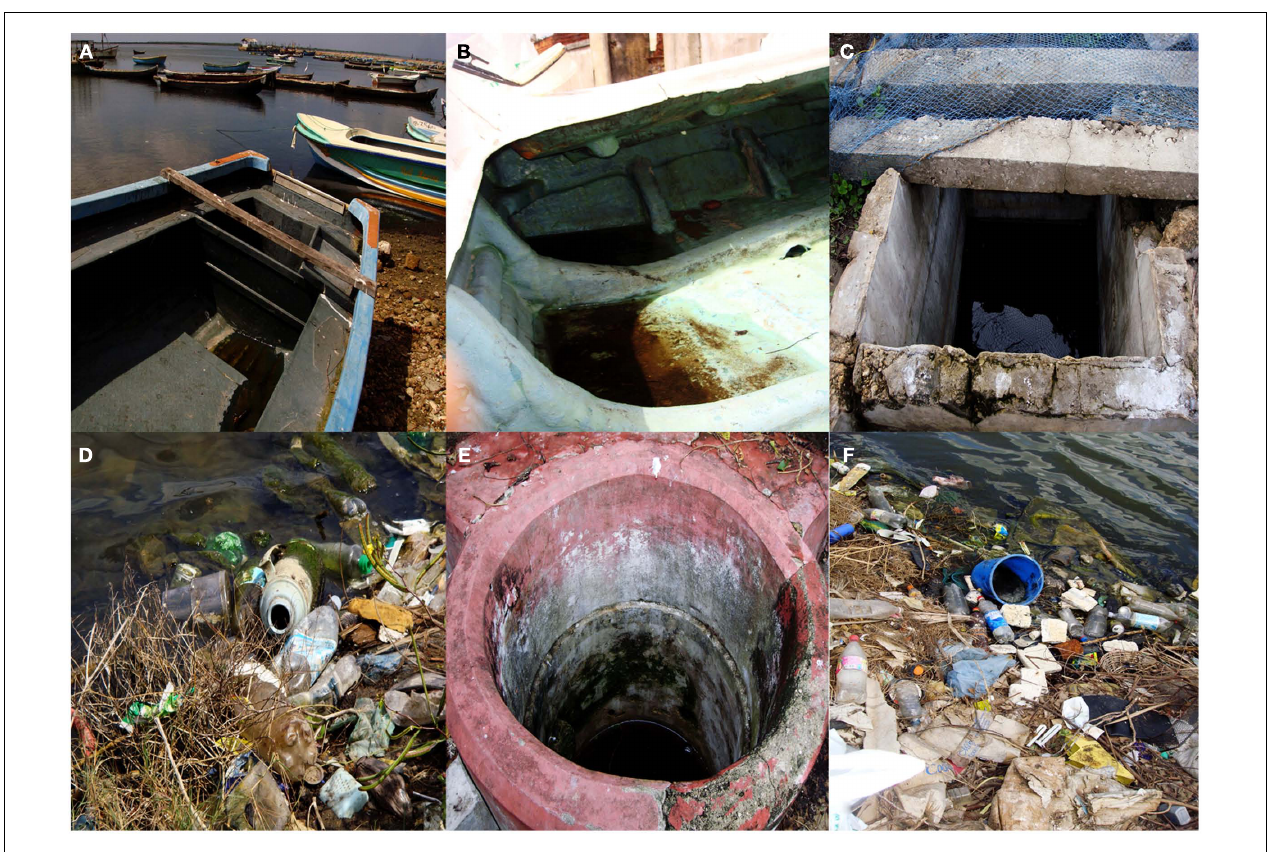
boats; (C,E) : abandoned wells; (D,F) discarded food and beverage containers (reproduced with permission from Ramasamy et al.,